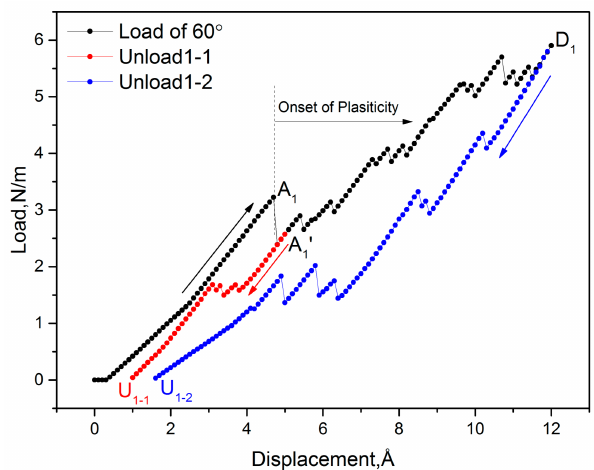
Figure 3. Load-displacement responses during unloading processes using the wedged indenter with half vertex angle of 60 ◦ .